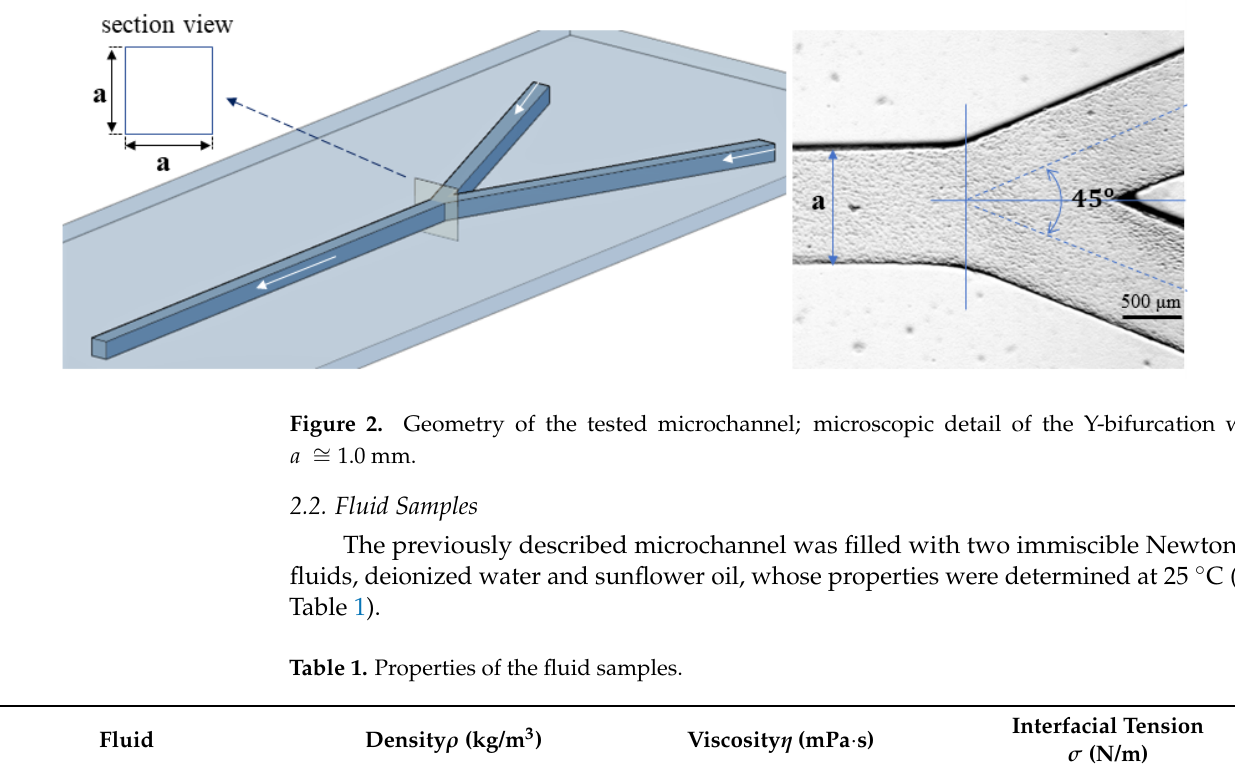
Figure 1. Influence on the water–wall contact of the polydimethylsiloxane (PDMS) time duration treatment in plasma: ( a ) 2.5 minutes; ( b ) 5 minutes.